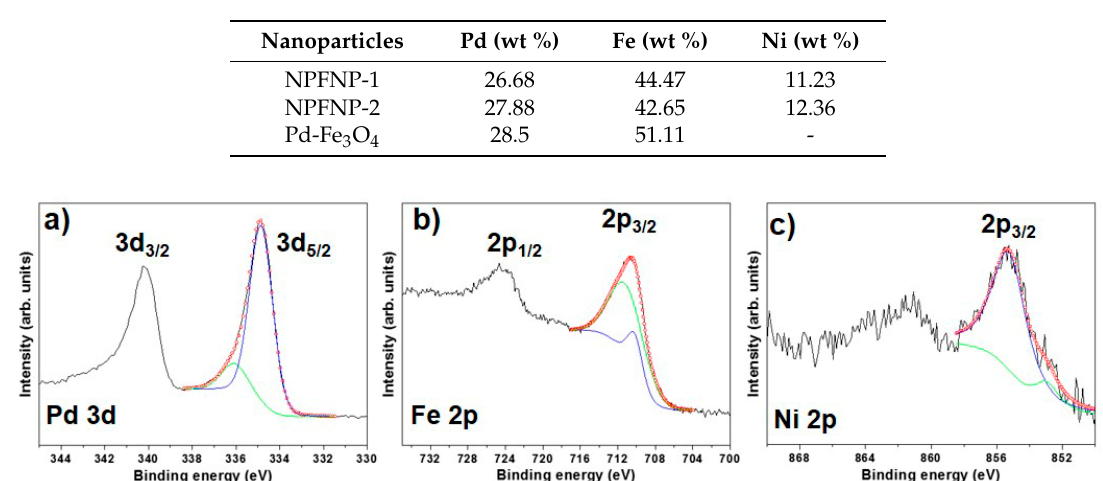
Figure 3. XPS spectra of NPFNP-2 ( a ) 3d 5/2 and 3d 3/2 lines of Pd; ( b ) 2p 3/2 and 2p 1/2 lines of Fe; ( c ) 2p 3/2 lines of Ni.